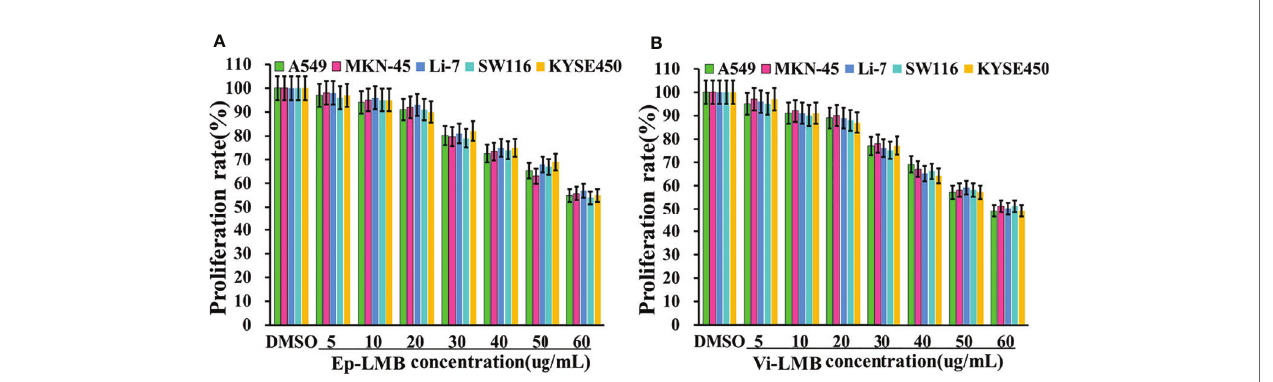
FIGURE 3 | The effect of immunomagnetic beads on the activity of A549 cells: (A) Effect of Ep-LMB on the proliferation rate of different cancer cells; (B) Effect of Vi- LMB on the proliferation rate of different cancer